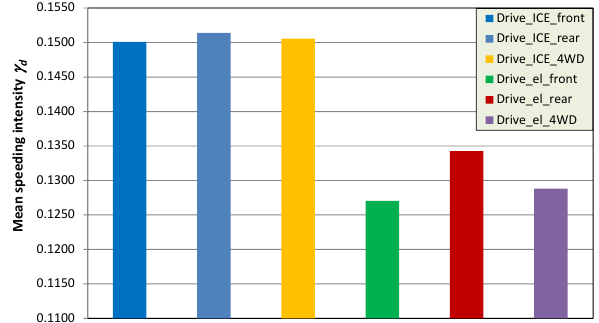
Fig. 8. Mean speeding intensity in speeding the vehicle straight ahead on a road with different adhesion coefficient under the wheels of the left and right side [own